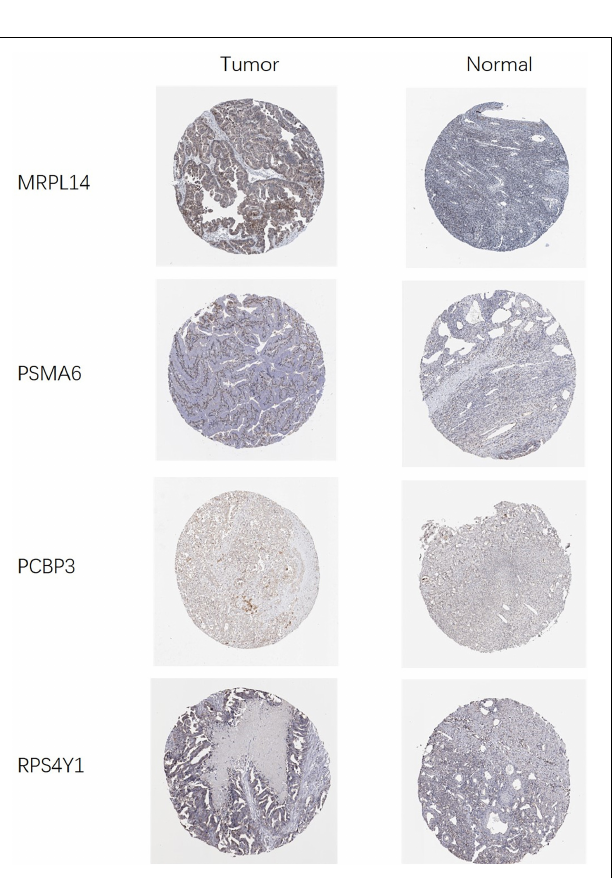
inhibits apoptosis of ovarian cancer cells (Lee,